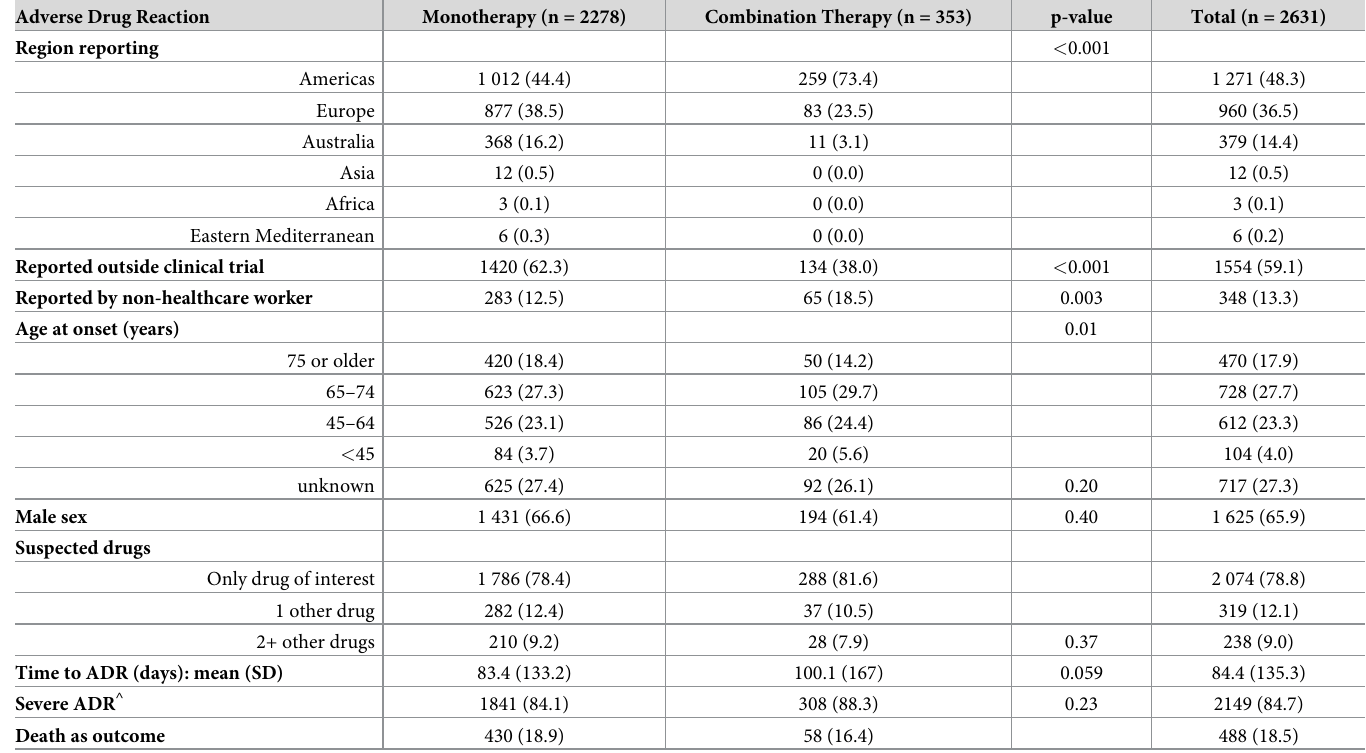
Table 1. Characteristics of cardiac ADRs associated with immune checkpoint inhibitor therapy in Vigibase (last accessed 11/23/2019) + � . Adverse Drug Reaction